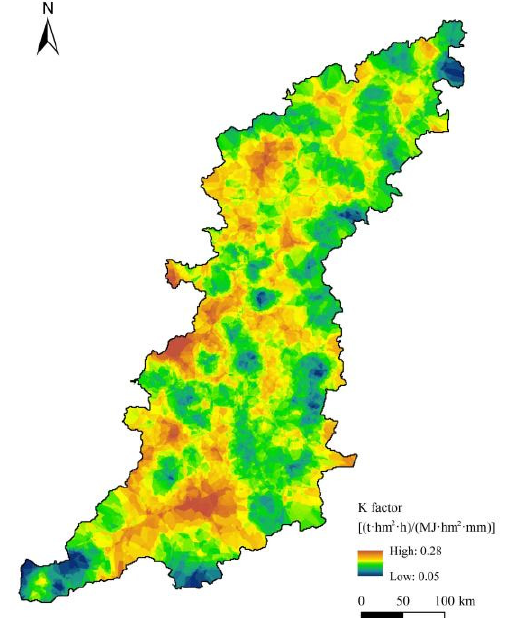
Figure 4. Spatial distribution of soil erodibility factor ( K ) in the Taihang Mountain area.